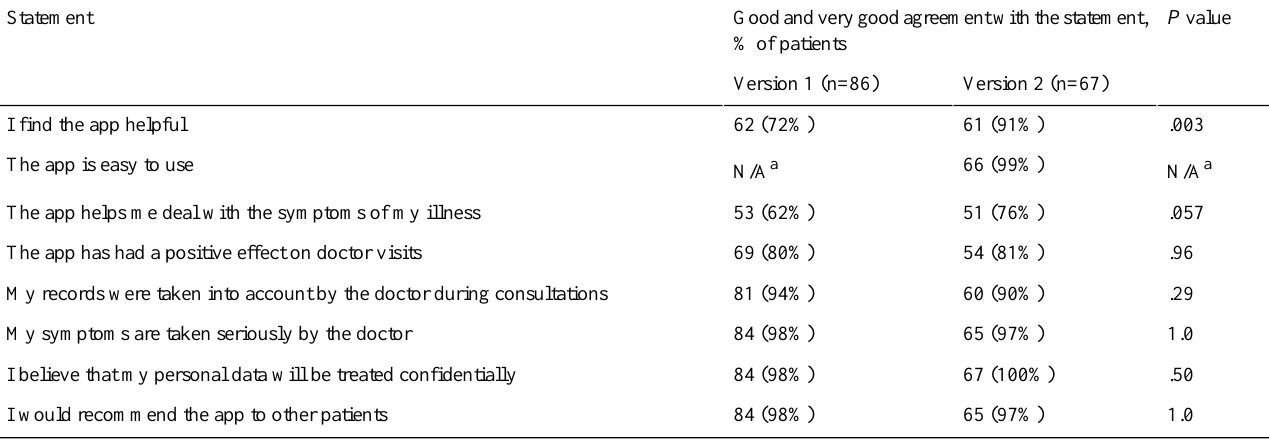
Table 2. Comparison of the usability of the two smartphone app